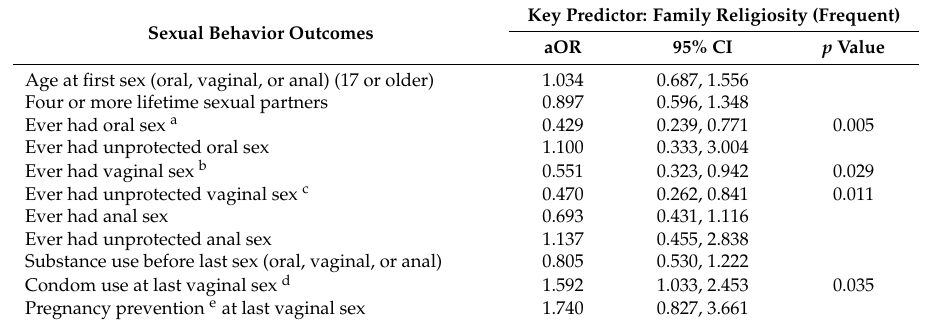
Table 5. Binary logistic regression models predicting emerging adults’ sexual behaviors. Sexual Behavior